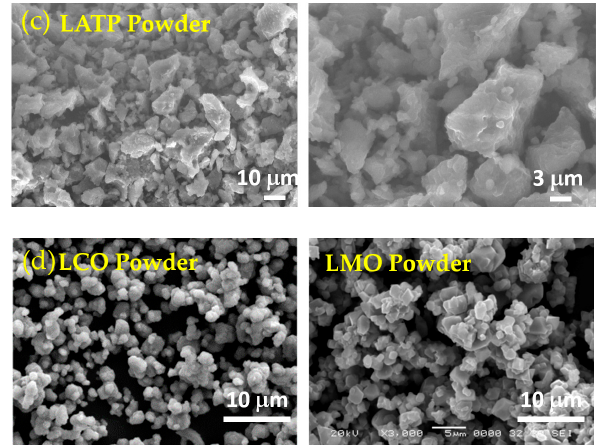
Figure 2. SEM images of ( a ) cross-section and ( b ) Top view of HSE-4/HSC-2/Al foil on carbon tape. SEM images of ( c ) LATP powder and ( d ) LCO and LMO powder. Scale bars in the images.